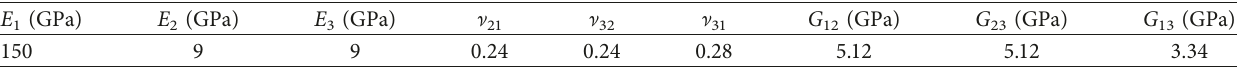
Table 1: The material properties of CFRP T700/FAW100.